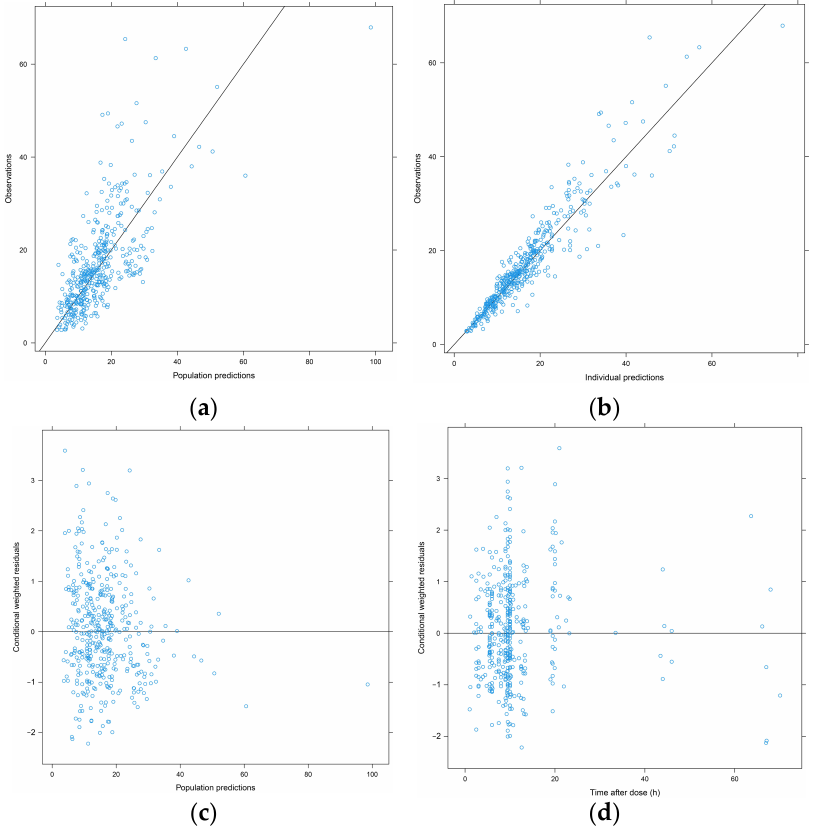
Figure 1. Goodness-of-fit plots of vancomycin population pharmacokinetic model. ( a ) observed concentration versus population prediction (PRED); ( b ) observed concentration versus individual prediction (IPRED); ( c ) conditional weighted residuals (CWRES) versus PRED; ( d ) CWRES versus time after dose (TAD).